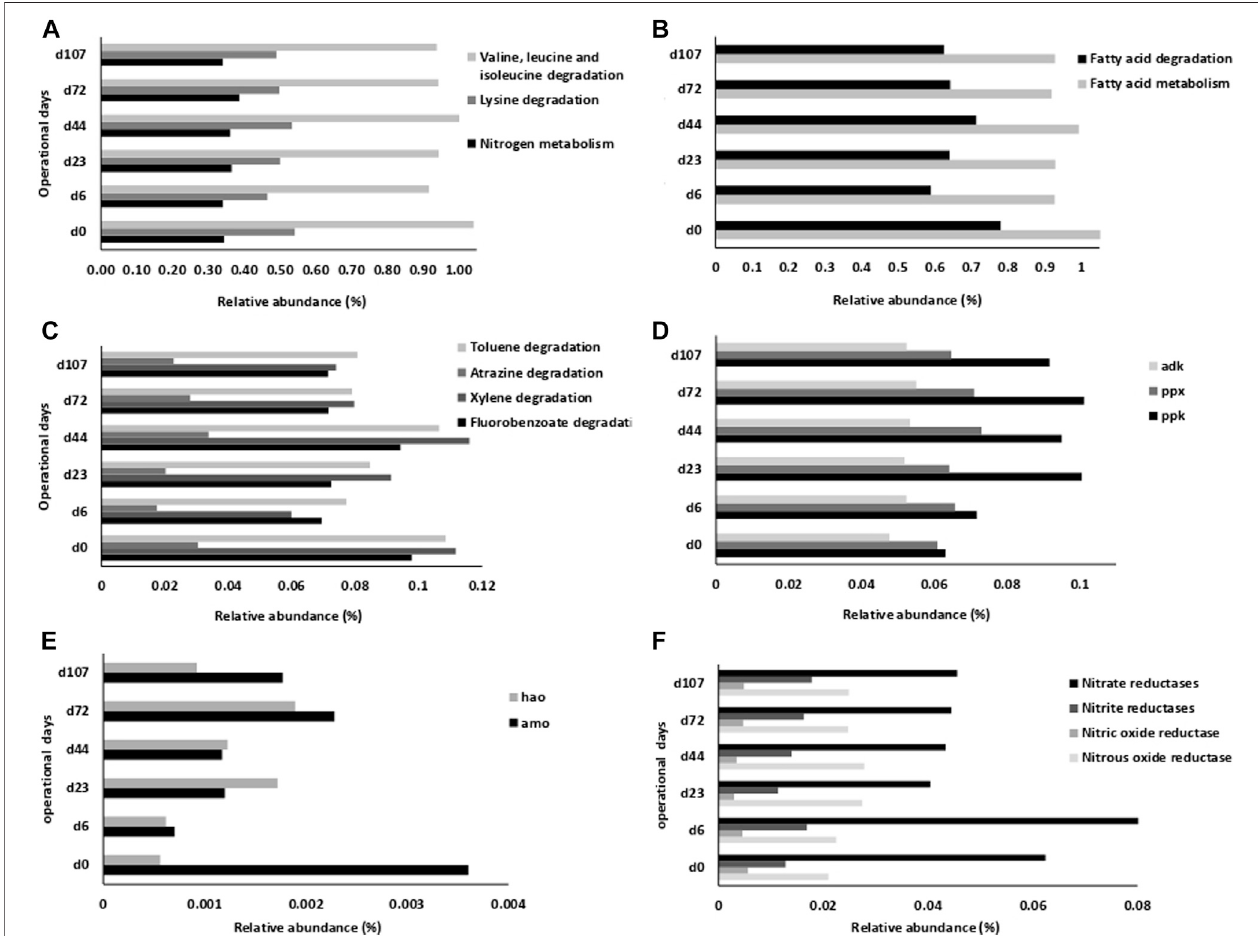
FIGURE 6 | Relative abundance of genes predicted for degradation of speci fi c amino acids and nitrogen metabolism (A) , fatty acid degradation and metabolism (B) , and xenobiotics degradation [toluene, atrazine, xylene, and fl uorobenzoate) (C) ]; Relative abundance of enzymes predicted for anaerobic phosphate release (adk, ppx) and aerobic phosphate accumulation (ppk) (D) , for nitri fi cation (amo and hao) (E) and for denitri fi cation (F) .